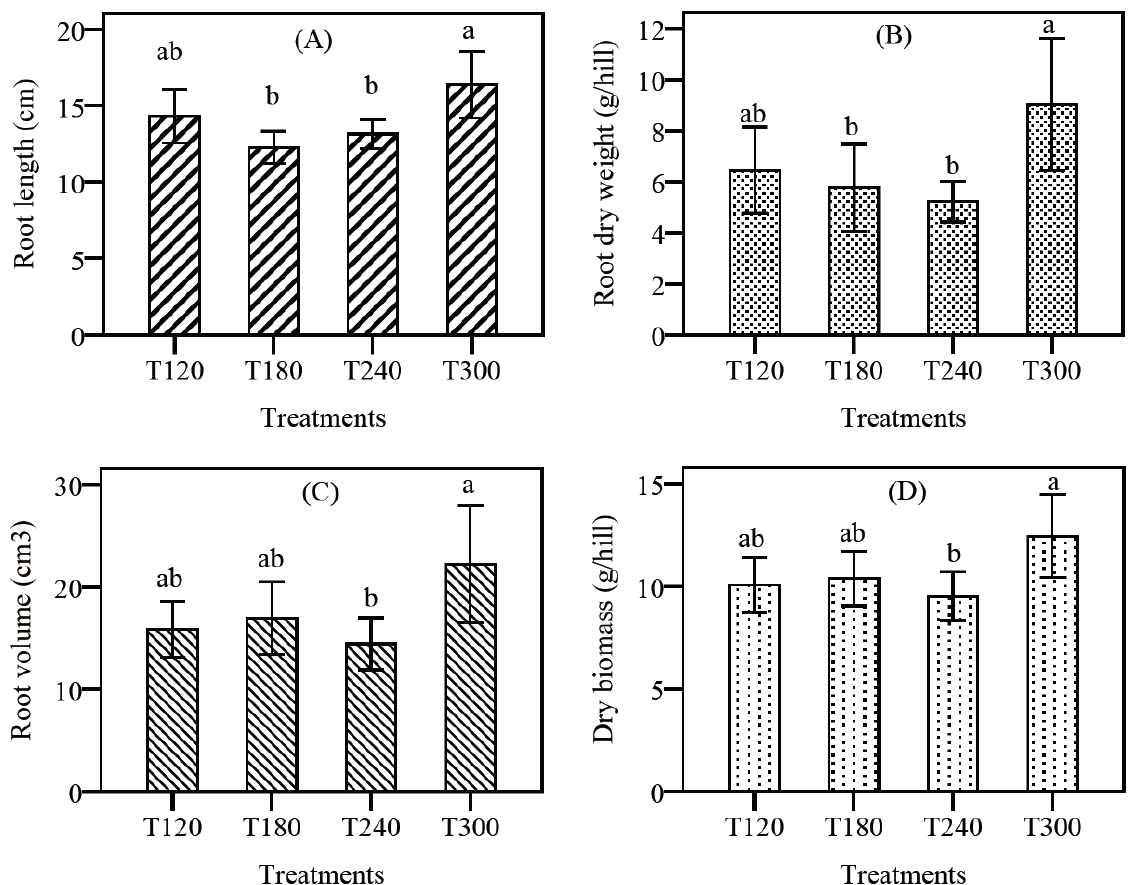
Figure 3. Effects of treatments on root length ( A ); dry weight ( B ); volume ( C ); and dry biomass ( D ) at active tillering.